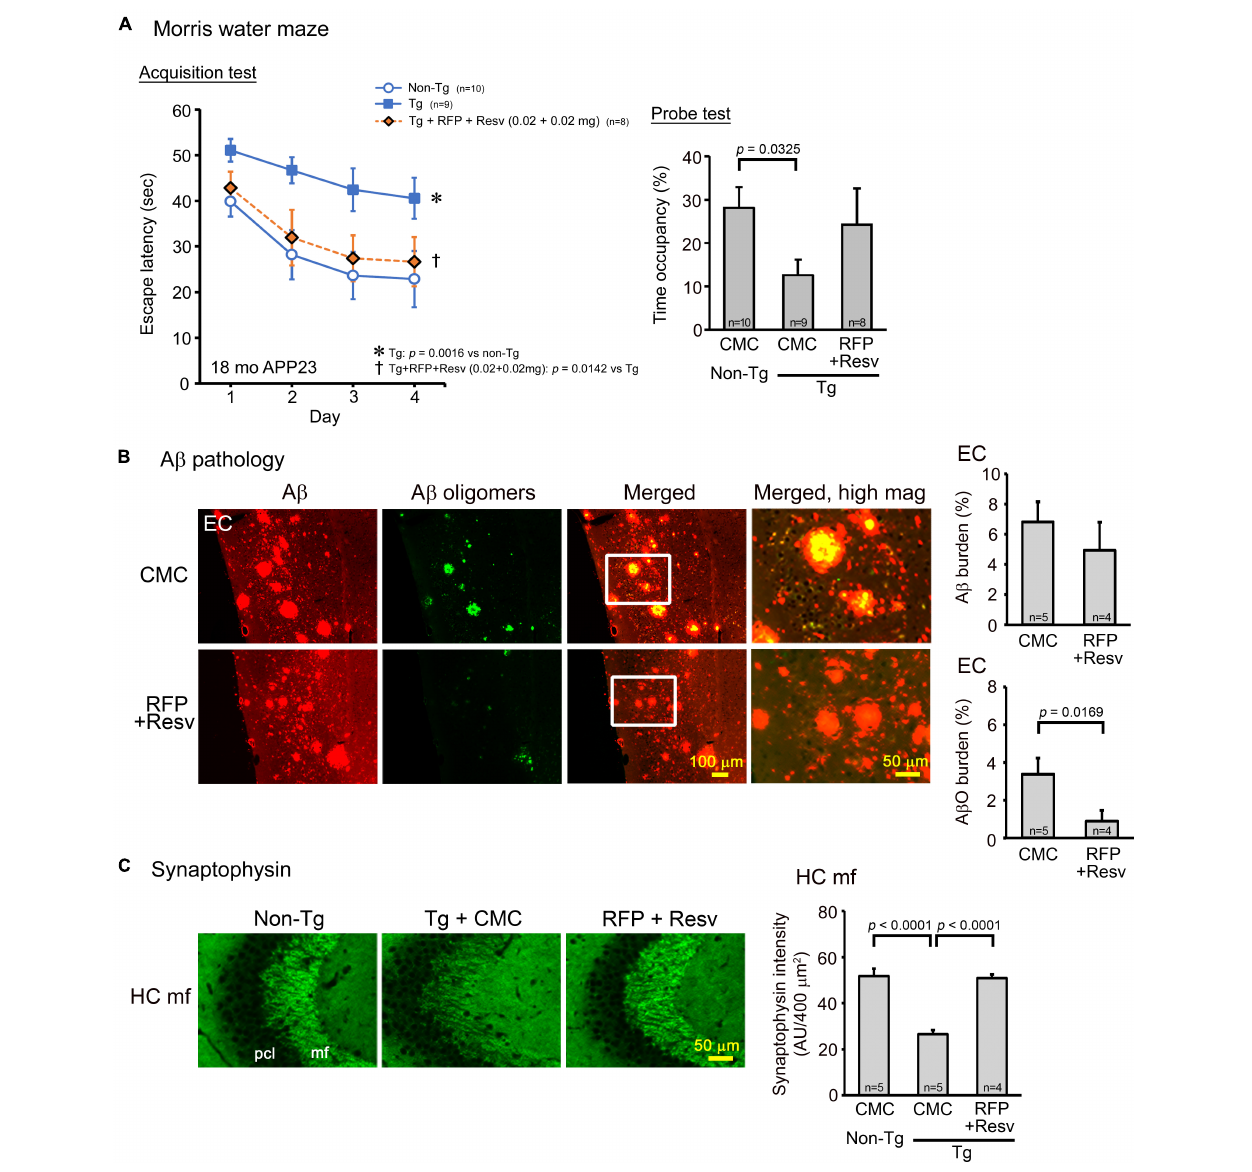
FIGURE 3 | Effects of intranasal rifampicin and resveratrol combination on memory and A β pathologies in APP23 mice. Drug solution containing 0.04 mg combinatorial medicine (0.02 mg each drug) or carboxymethylcellulose (CMC) was intranasally administered every day into 16–17-month-old mice for 1 month. (A) In the Morris water maze acquisition test, the combinatorial medicine showed a significant improvement of mouse memory to a level similar of non-Tg littermates. (B,C) After the water maze task, brain sections were stained with antibodies for A β oligomers (11A1), pan-A β , and synaptophysin. (B) The level of amyloid plaques in the entorhinal cortex (EC) did not change by the treatment, whereas the level of A β oligomers (A β O) was significantly reduced. (C) The level of synaptophysin in the hippocampal mossy fibers (HC mf) was significantly recovered by the treatment to almost the same level as non-Tg littermates. pcl, pyramidal cell layer. AU, arbitrary unit. Values represent the mean ±